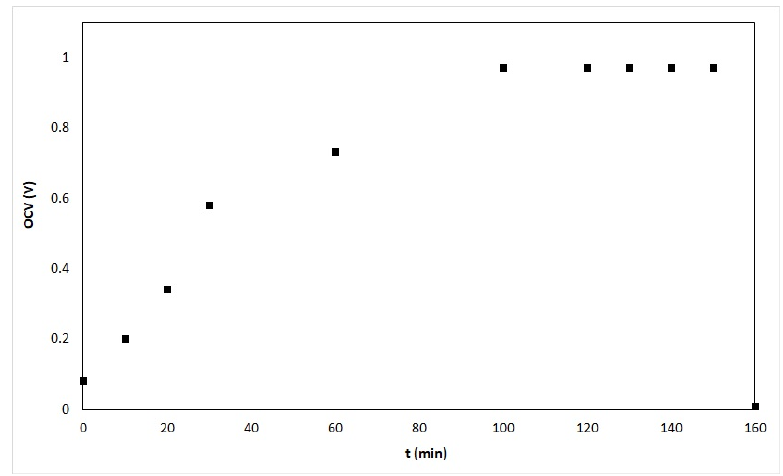
Figure 2. Evolution of the OCV during anode reduction.